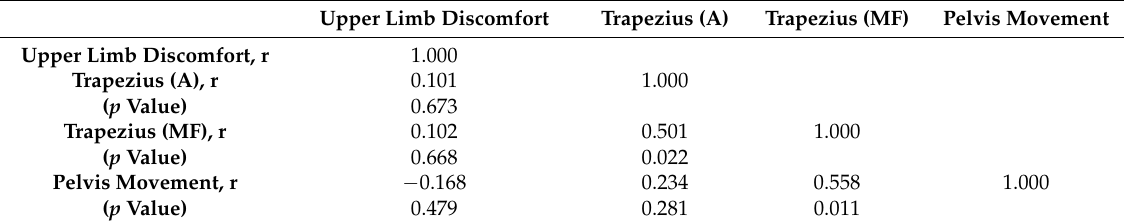
Table 6. Change score correlations (r) between upper limb discomfort, muscle fatigue [amplitude (A) and median frequency (MF)] and pelvis movement over 2 h prolonged sitting.